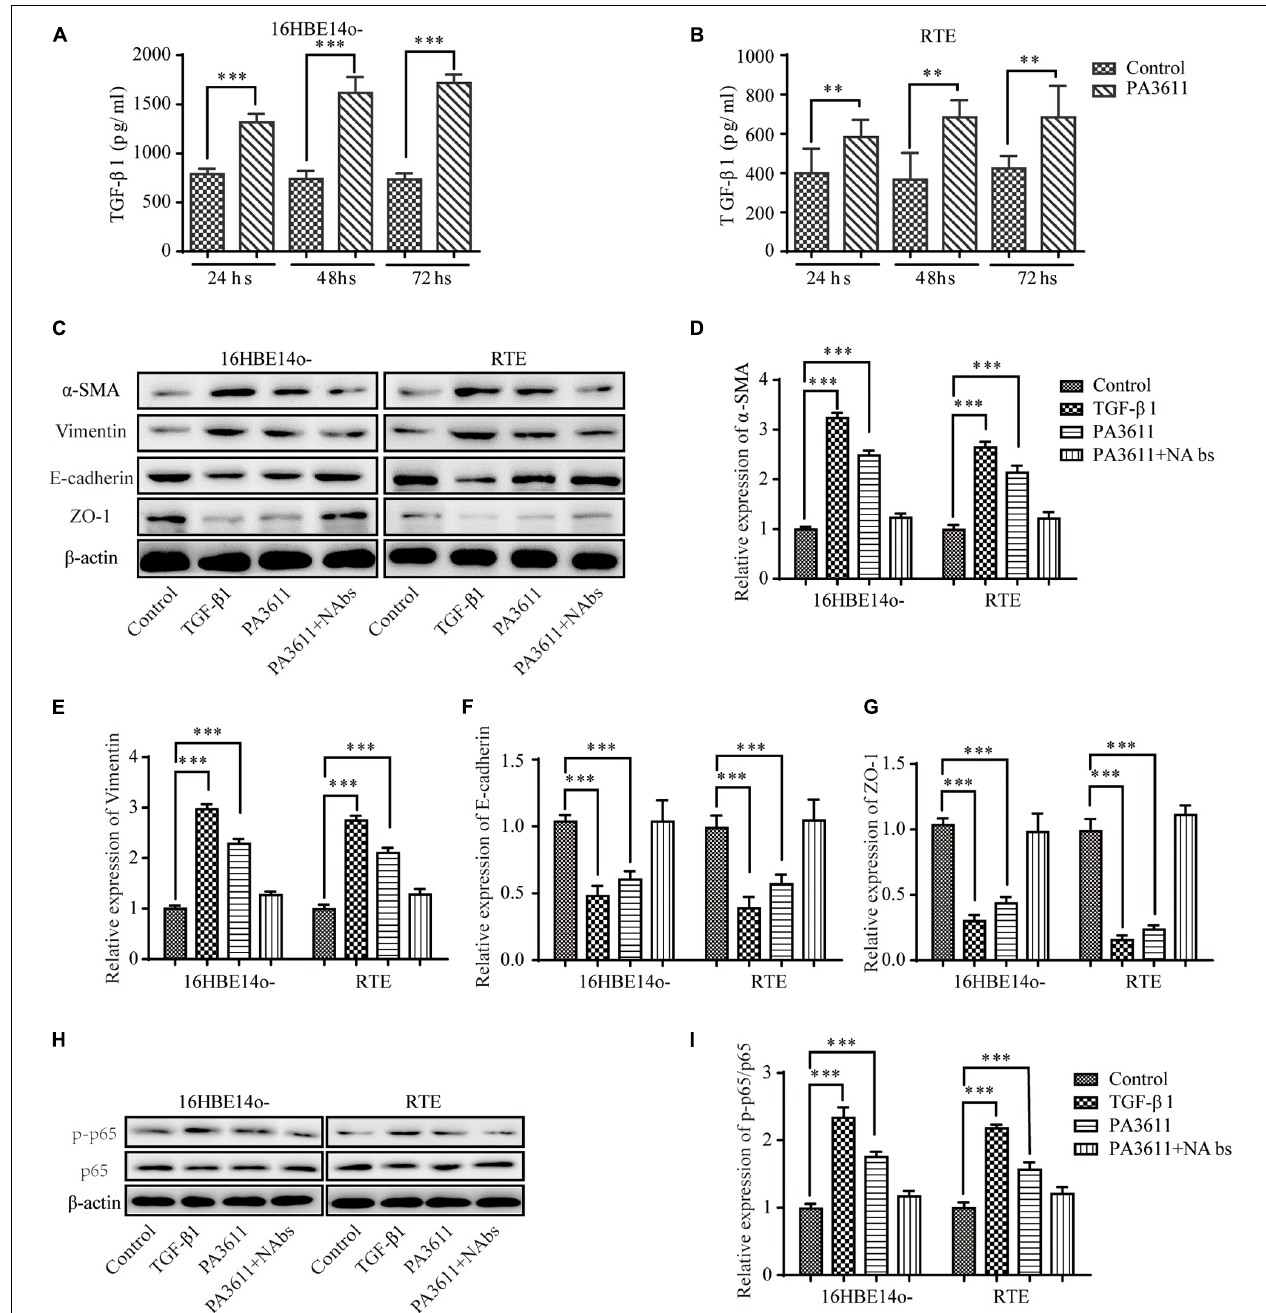
FIGURE 2 | Effects of PA3611 and TGF- β 1 on the expression of p65 phosphorylation and EMT-related markers. 16HBE14o- and RTE cells were treated with PA3611 (10 µ g/mL), and the TGF- β 1 levels in 16HBE14o- and RTE cell culture supernatants were detected by an enzyme-linked immunosorbent assay (ELISA) at 24, 48, and 72 h (A,B) . 16HBE14o- and RTE cells were treated with PA3611 (10 µ g), TGF- β 1 (2 ng/mL) or PA3611 (10 µ g) plus TGF- β 1-neutralizing antibody (10 µ g/mL) for 48 h, and EMT-related markers ( α -SMA, vimentin, E -cadherin and ZO-1, C–G ) and p65 phosphorylation (H,I) were then assessed by Western blot analysis. All the presented graphs are representative of the results of three independent experiments. The data are presented as the mean ± SD. ∗ P < 0.05, ∗∗ P < 0.01, ∗∗∗ P < 0.001, vs. the control group.